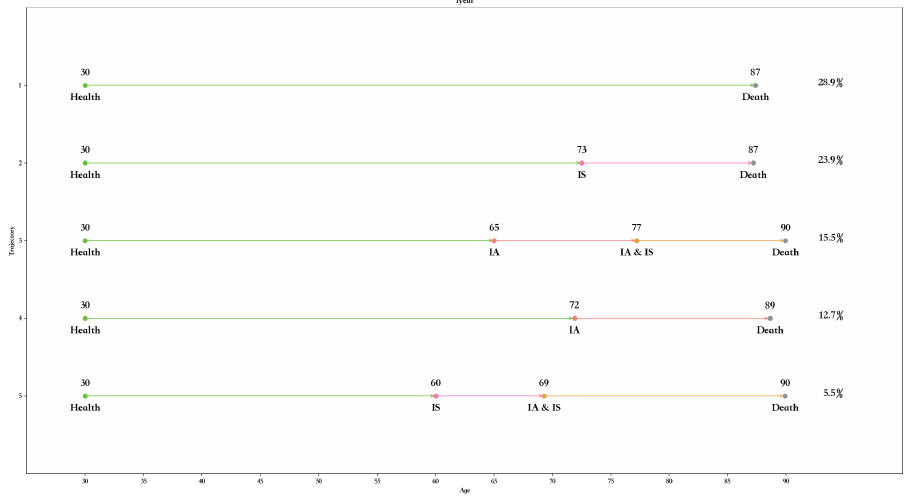
Figure 5. Disease progression trajectory of 1-year interval group.